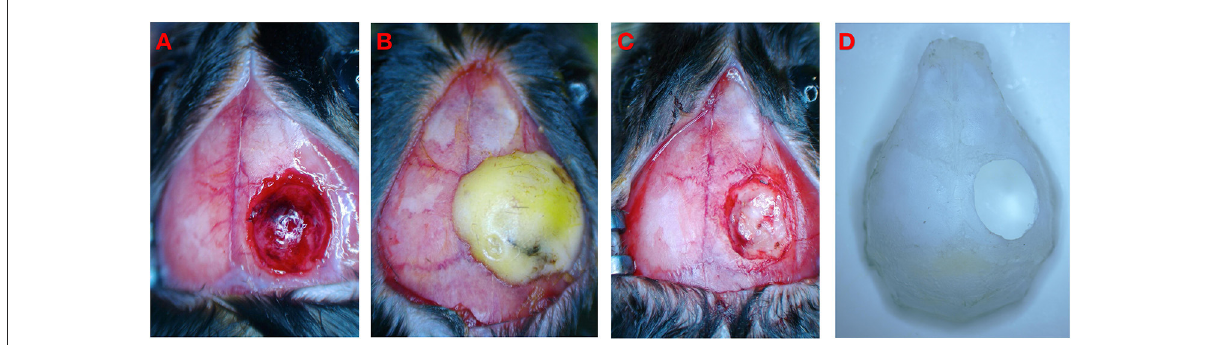
FIGURE2 Schematic diagram of experimental operation. (A) Brain injury after CCI. (B) Close bone window after CCI. (C) CCI + DC group underwent bone window removal and contused tissue removal. (D) Schematic diagram of bone